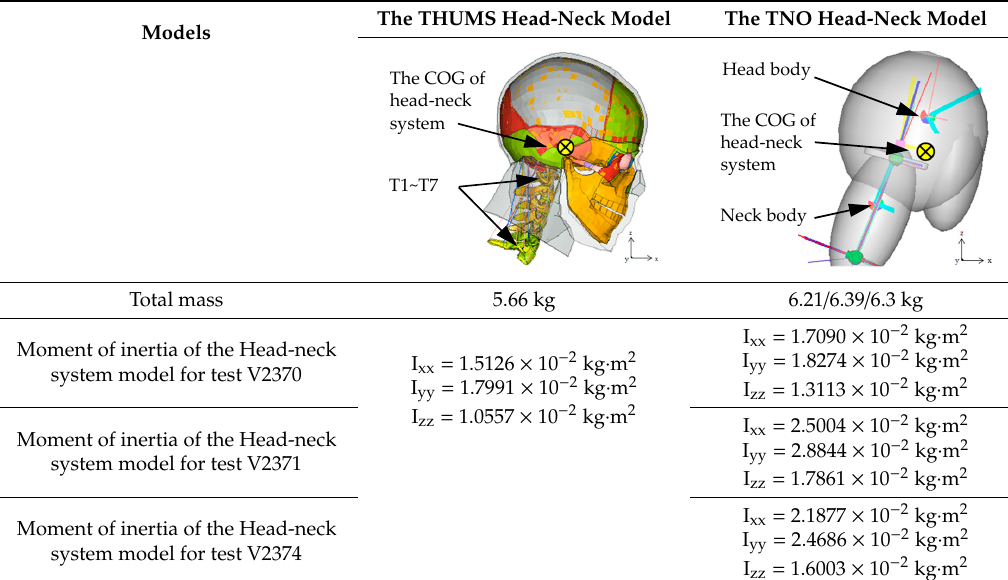
Table A1. Comparison of inertial properties of the head–neck system from the THUMS and TNO models.